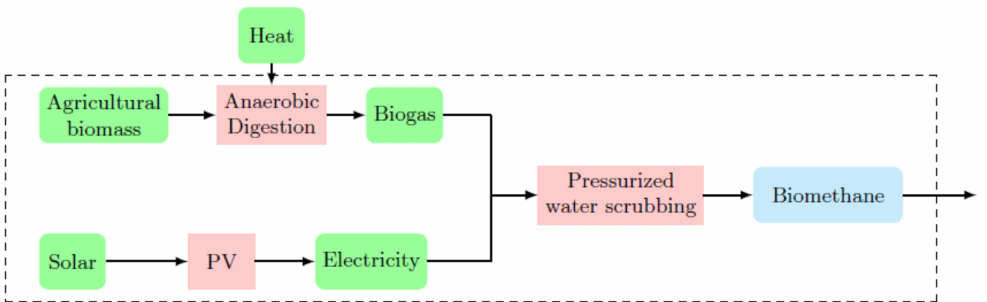
Figure 7. Process flowchart for biogas upgrading using pressurized water scrubbing. Resources and intermediate energy carriers are depicted as green, processes red and final products and energy carriers